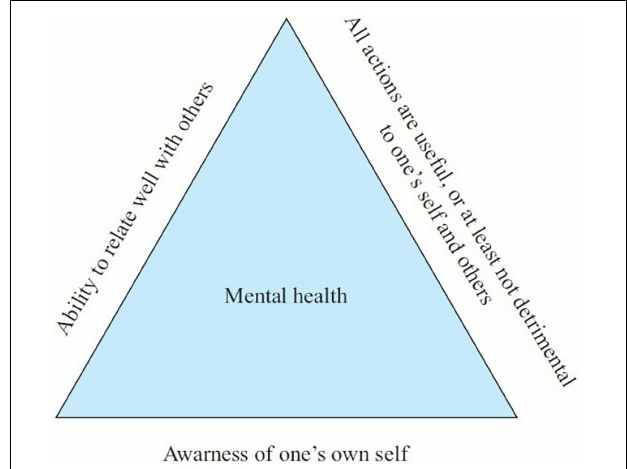
FIGURE 1 | Triangular model of mental